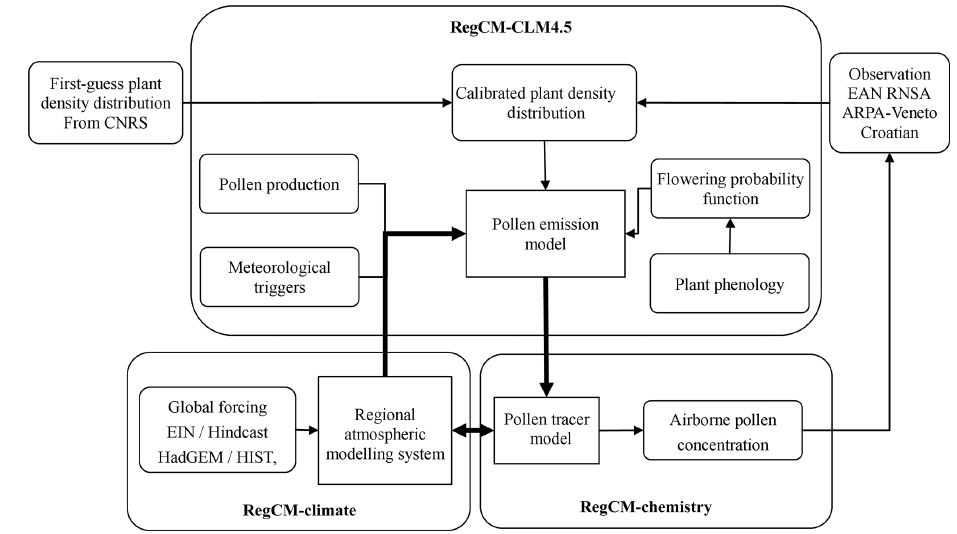
Figure 1. Ragweed pollen modelling within online RegCM-pollen simulation framework.